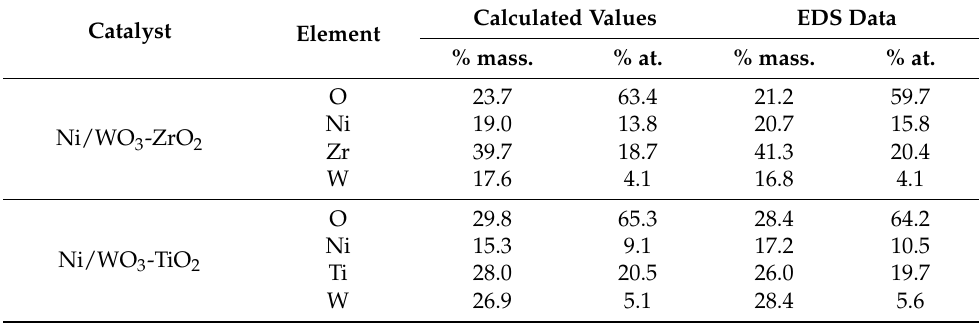
Table 2. The composition of the 20%Ni/18%WO 3 -ZrO 2 , 16%Ni/20%WO 3 -TiO 2 catalysts. Calculated Values EDS Data Catalyst Element % mass. %